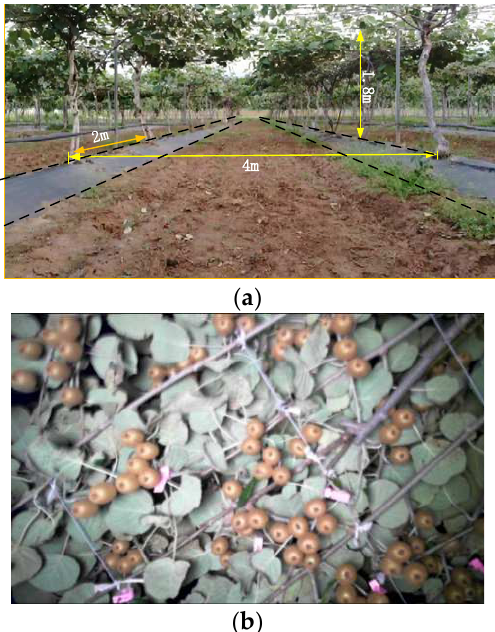
Figure 1. Kiwifruit shelf cultivation model. ( a ) Trellis cultivation mode. ( b ) Clustered kiwifruit.